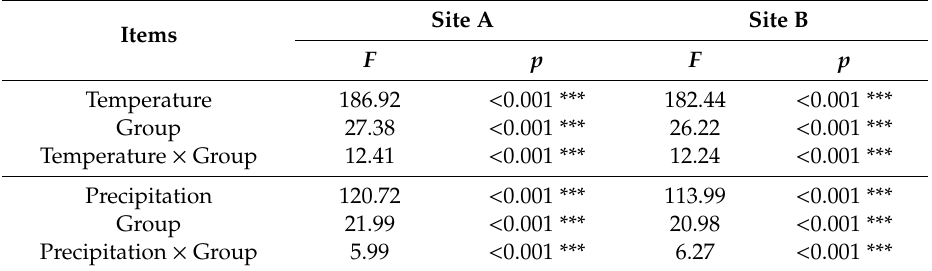
Figure 6. Correlation coefficients between seasonal temperatures (Tmean), precipitations (P), and radial growth of group AD2 at site A ( a ) and BS1 at site B ( b ). Table 5. Analysis of covariance (ANCOVA) of climatic factors on radial growth.